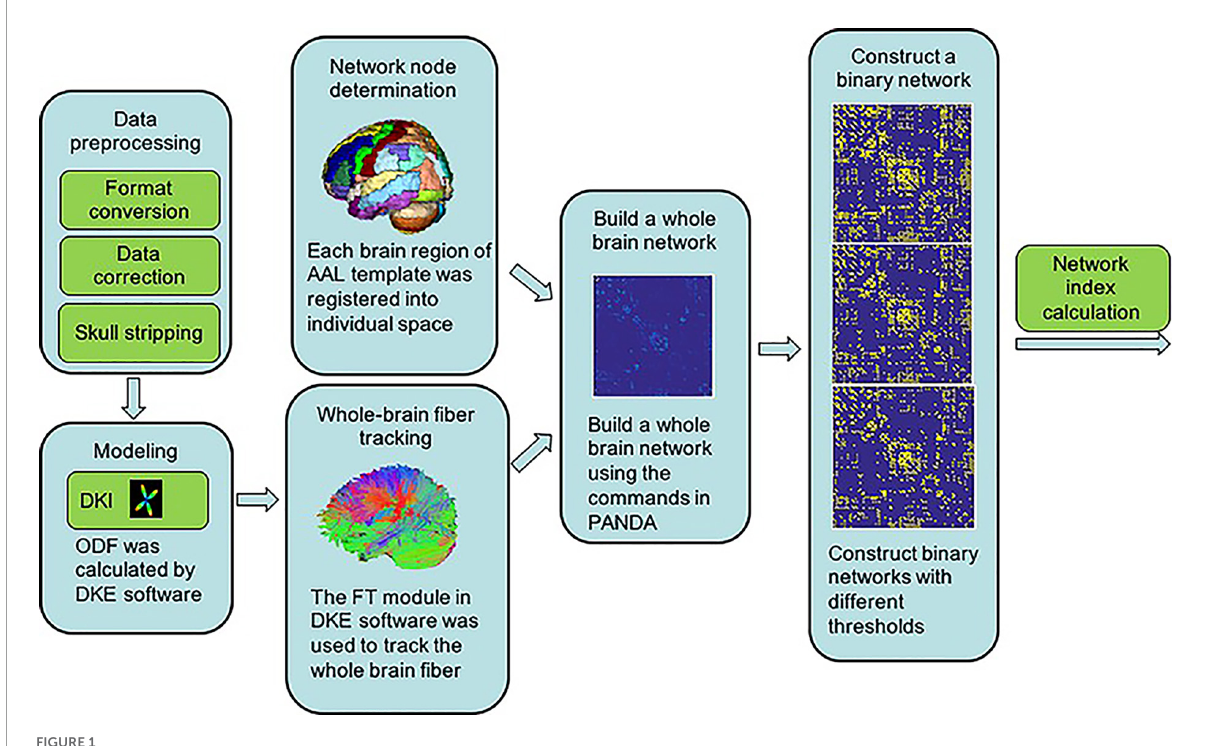
FIGURE1 Schematic diagram outlining the construction of the brain network.